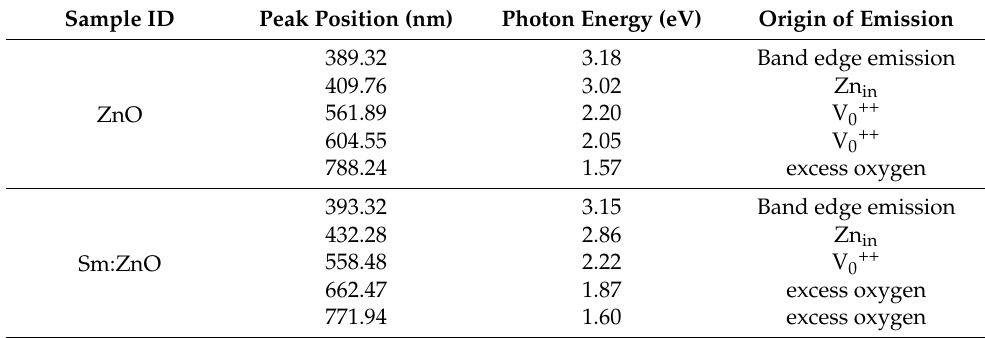
Table 2. The peak positions and their origin of de-convoluted PL spectra for all